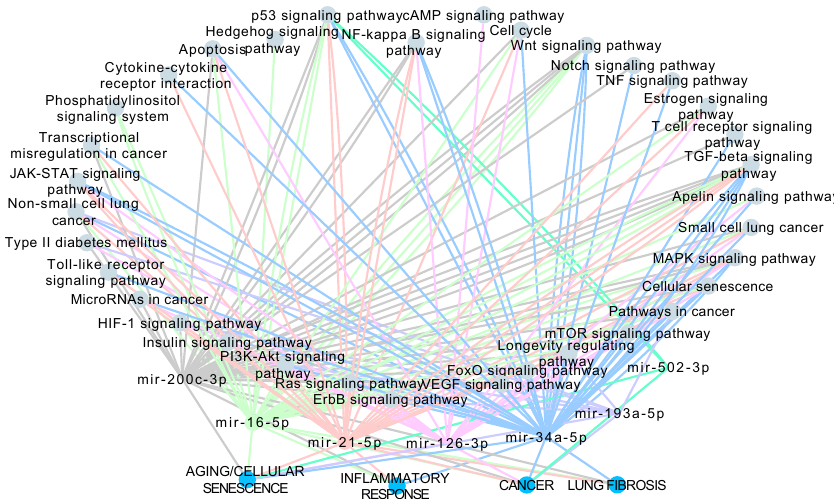
Figure 4. Network of the ILA-associated miRNAs and their enriched pathways involved in the biological processes ( A ) aging/cellular senescence, ( B ) inflammatory response, ( C ) cancer and ( D ) lung fibrosis. Nodes represent either pathways, miRNAs, or biological processes. Edge colors are specific for each miRNA.